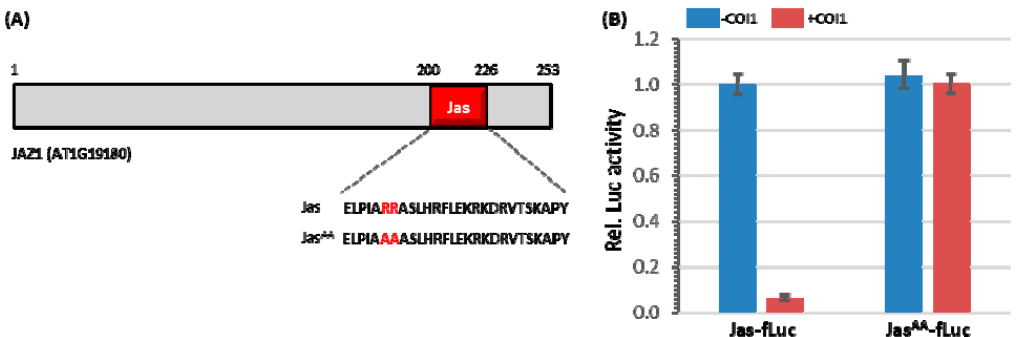
Figure 2. The Jas-motif of JAZ1 is su ffi cient to target fLuc for degradation. ( A ) Schematic and amino acid residues of JAZ1 Jas-motif. The red bar indicates residues of the Jas-motif with the sequence shown below. The red letters highlight wild-type residues and point mutations in Jas and Jas AA , respectively. ( B ) Arabidopsis leaf protoplasts prepared from coi1 mutant plants were co-transfected with protein-fusion reporter plasmids encoding Jas-fLuc or Jas AA -fLuc under the control of UBQ10 promoter and e ff ector plasmid encoding COI1 under the control of UBQ10 promoter. Firefly luciferase (fLuc) activities were normalized to Renilla luciferase (rLuc) activities. Reporter activities of Jas-fLuc without e ff ector vector were set to one. Values represent means ( ± SE) of four independently transformed batches of protoplasts.